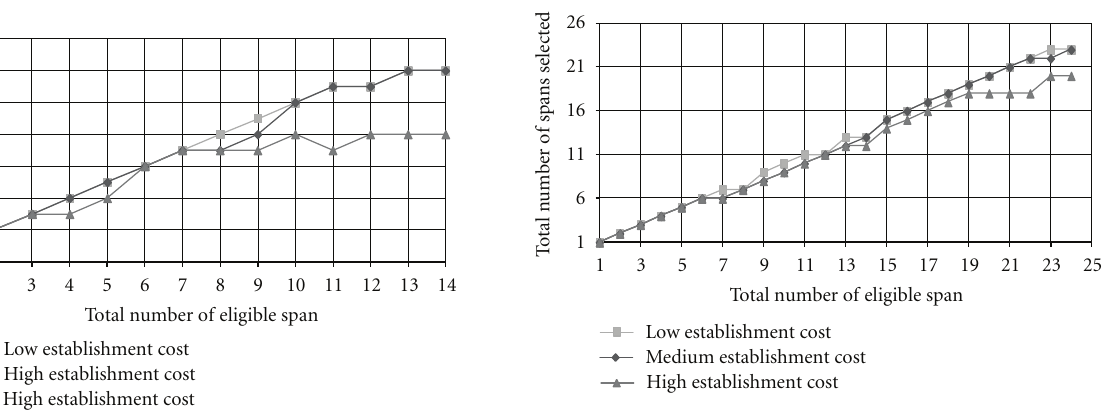
Figure 10: Variation of total number of selected spans for 15-node 30-span network.